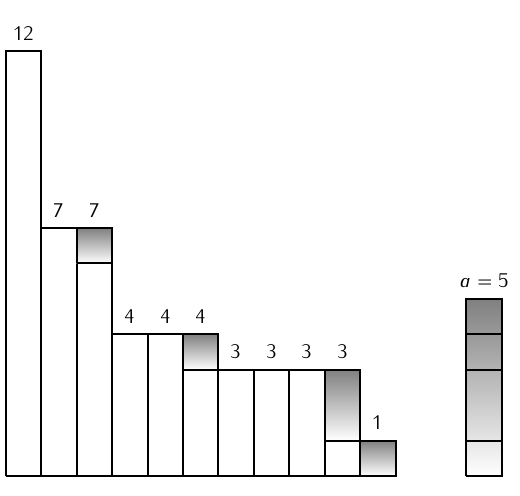
Fig 1. Geometric view of L